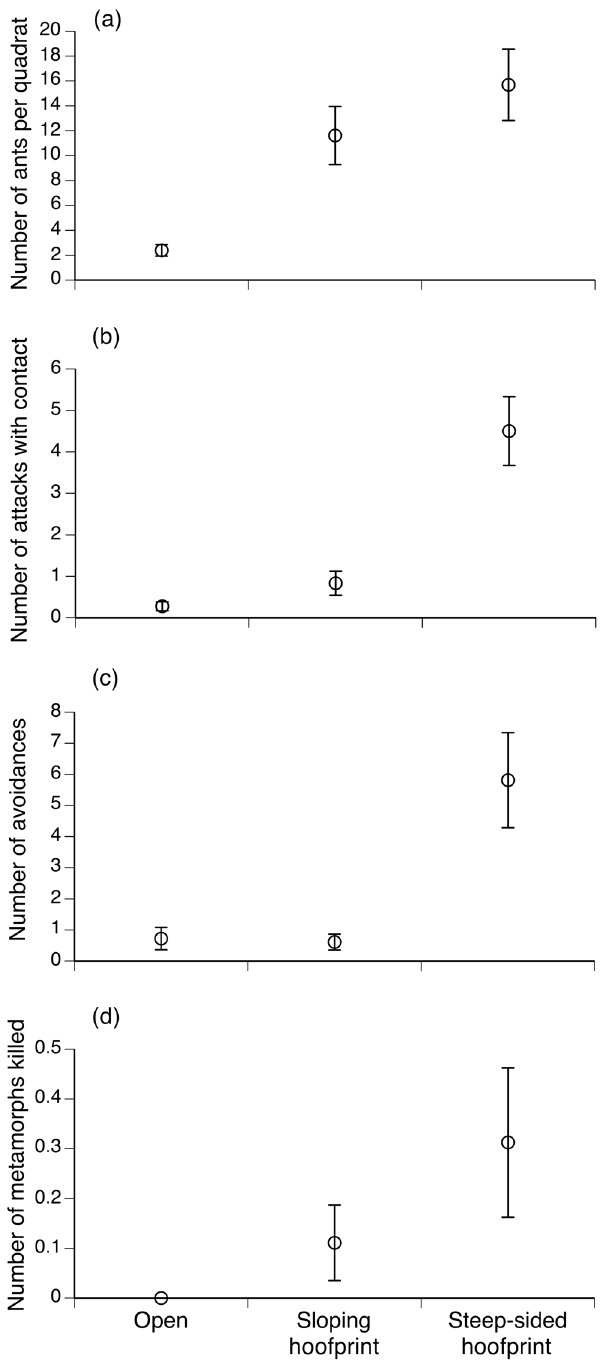
Figure 5. Vulnerability of metamorph cane toads to predation by ants on open substrates and in hoofprints. The panels show the effects of microhabitat on the number of ants per quadrat (a), the number of times that toads were attacked (seized or bitten) by ants (b), the number of times that toads avoided ant attack by moving away (c), and the number of metamorph toads killed by ant attack (d). Data are means 6 1 SE.